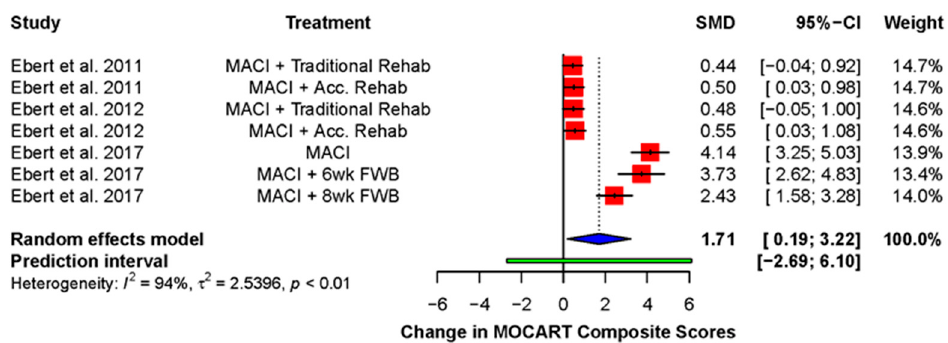
Figure 4. Forest plot on the improvement in MOCART composite score during post-operative follow-up. (Abbreviations: MACI, Matrix-induced autologous chondrocyte implantation; Acc., accelerated; FWB, full weight-bearing; SMD, standardized mean difference; CI, Confidence Intervals).